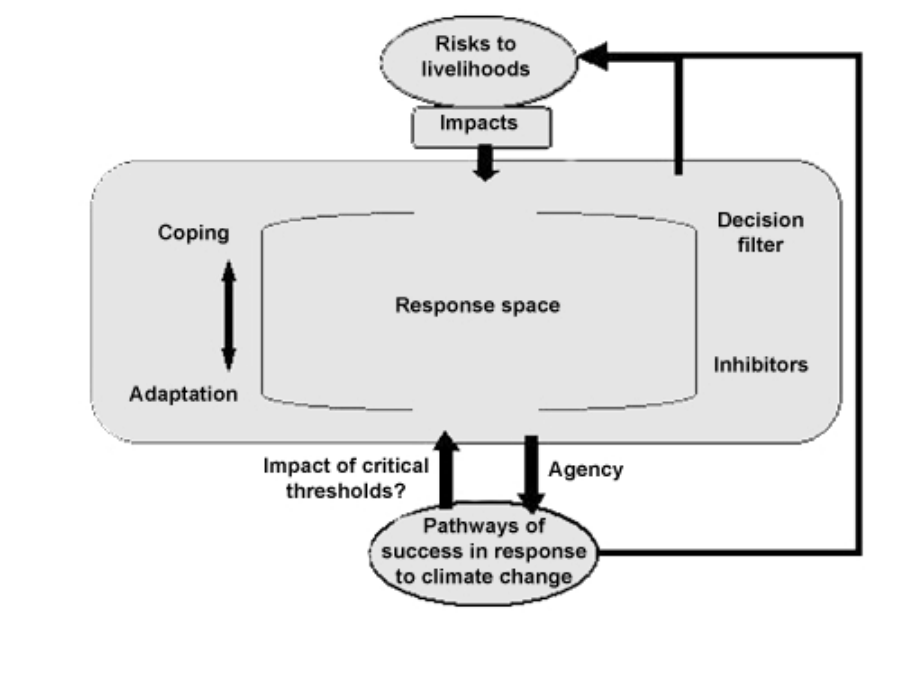
Fig. 1. The conceptualized ‘response space’ of adaptation. Note: risks include: climate (drought, flooding, seasonality, variability, intensity of event), environmental (level of water availability, rangeland quality, degradation, soil/vegetation quality) and socioeconomic (limited knowledge, infrastructure and technology, poor health or economy, changing types of governance, culture or politics, demography,